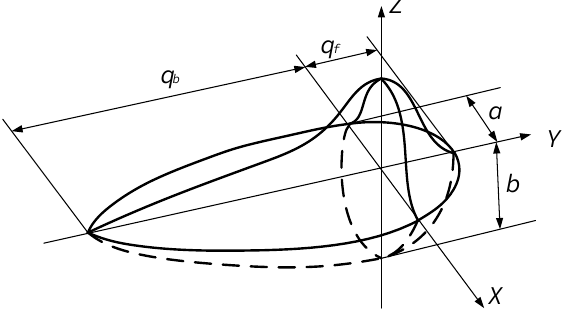
Figure 2. Applying displacement constraints on the substrate.